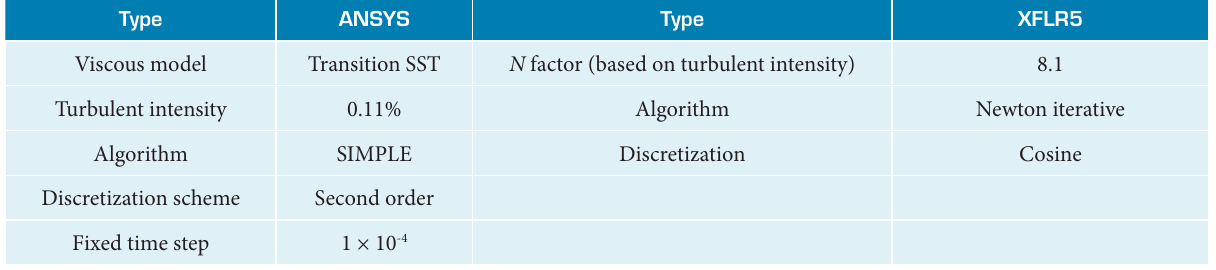
Table 2. Settings for ANSYS FLUENT 14.0 and XFLR5.